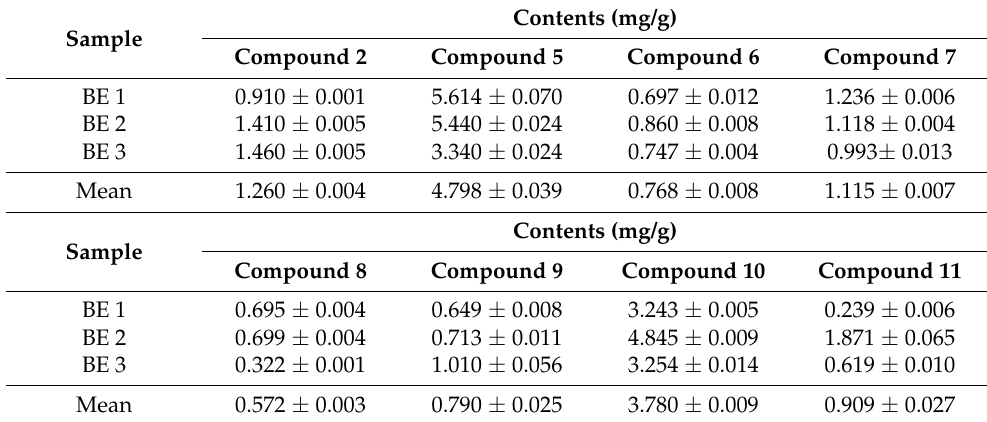
Table 5. Content of compounds 2 and 5 – 11 in the Benincasae